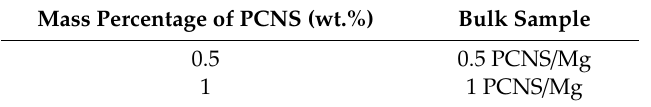
Table 1. Tags of samples without polyvinyl pyrrolidone (PVP) pretreatment by regular methods. Mass Percentage of PCNS